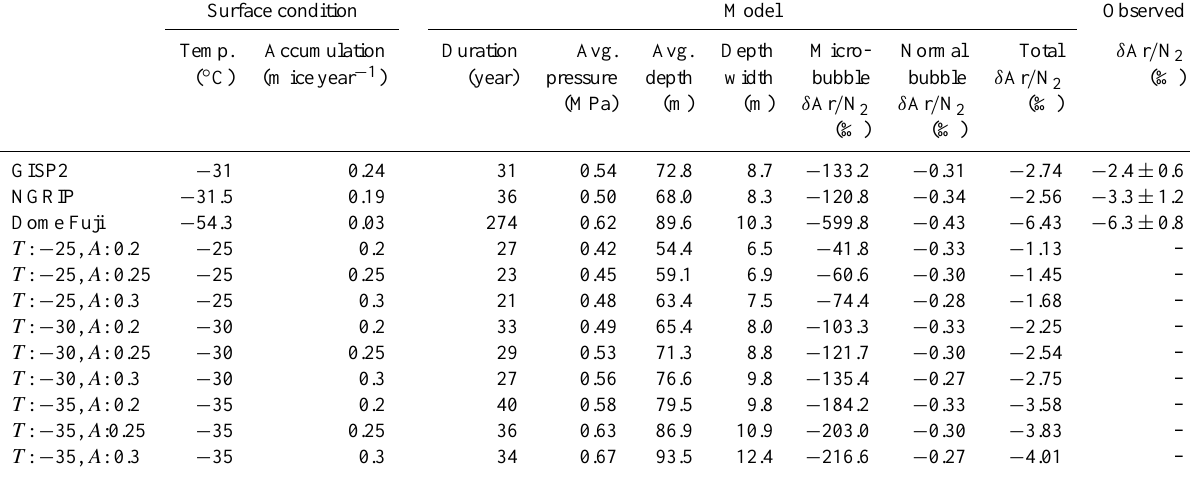
Table 3. Modeled and observed δ Ar / N 2 in various conditions with microbubble contribution of 2%. In the first column, T indicates tem- perature ( ◦ C) and A indicates accumulation rate (miceyear − 1 ). Duration is the time that bubbles experience from the depth of 20% bubble closure to the depth of complete bubble close-off. Average pressure is the average overloading pressure between the depths of the 20% bubble closure and complete bubble close-off. The average depth is the middle depth between the 20% bubble closure and complete bubble close-off. Depth width is the depth range from 20 to 100% bubble closed. Microbubbles, normal bubbles, and total δ Ar / N 2 are the values after all the bubbles are closed (i.e., in ice cores). Observed δ Ar / N 2 are the values corrected for the post-coring fractionation in Table 2.